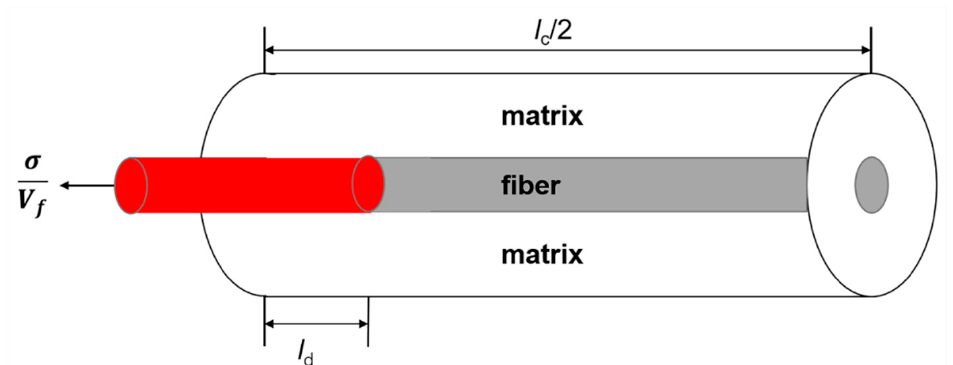
Figure 2. The unit cell of damaged composite.